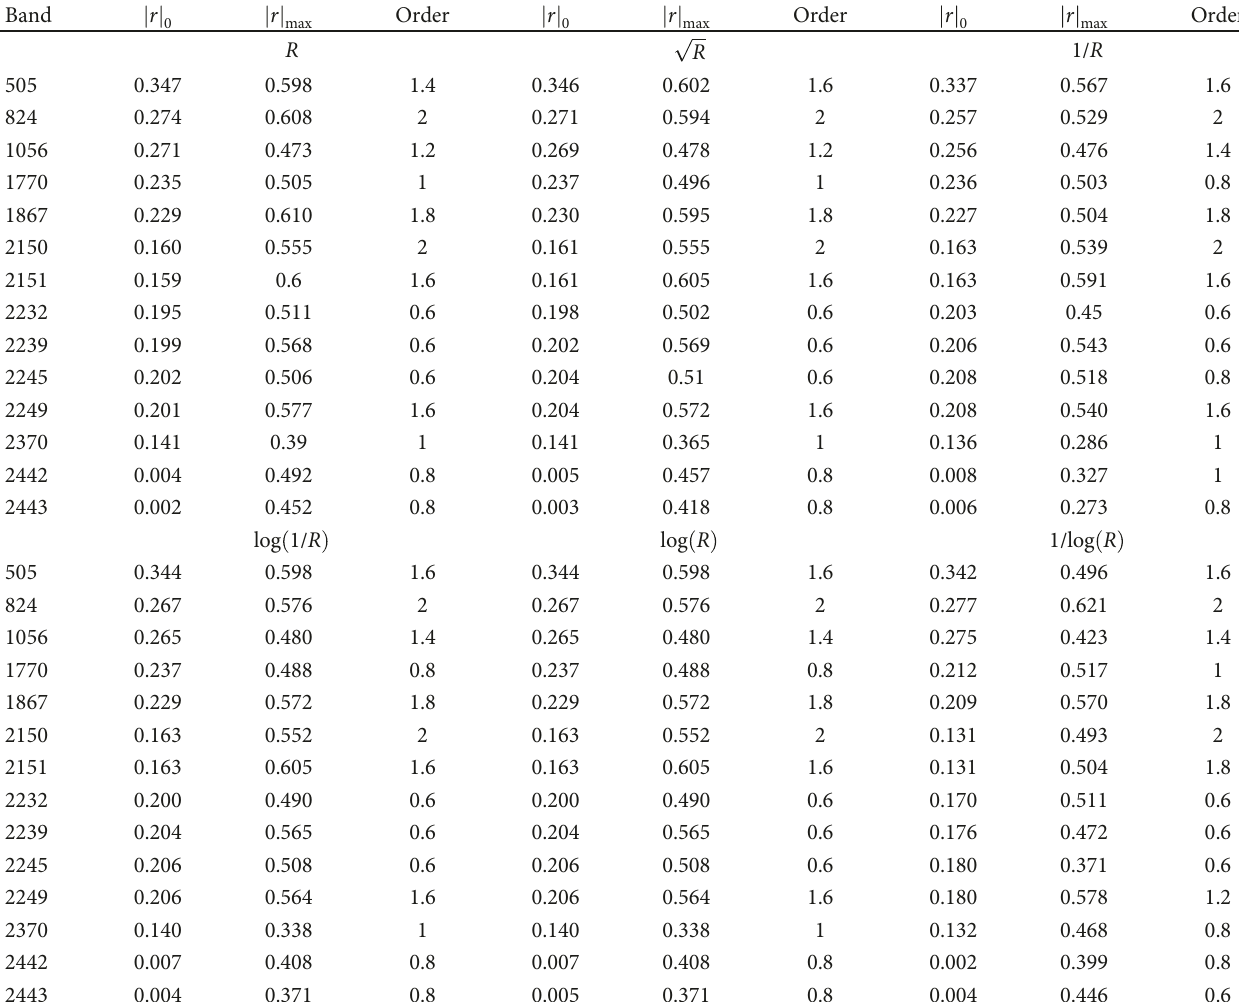
Table 4: The absolute value of correlation coe ffi cient of each mathematic conversion and the maximal absolute value of correlation coe ffi cient after di ff erential with corresponding